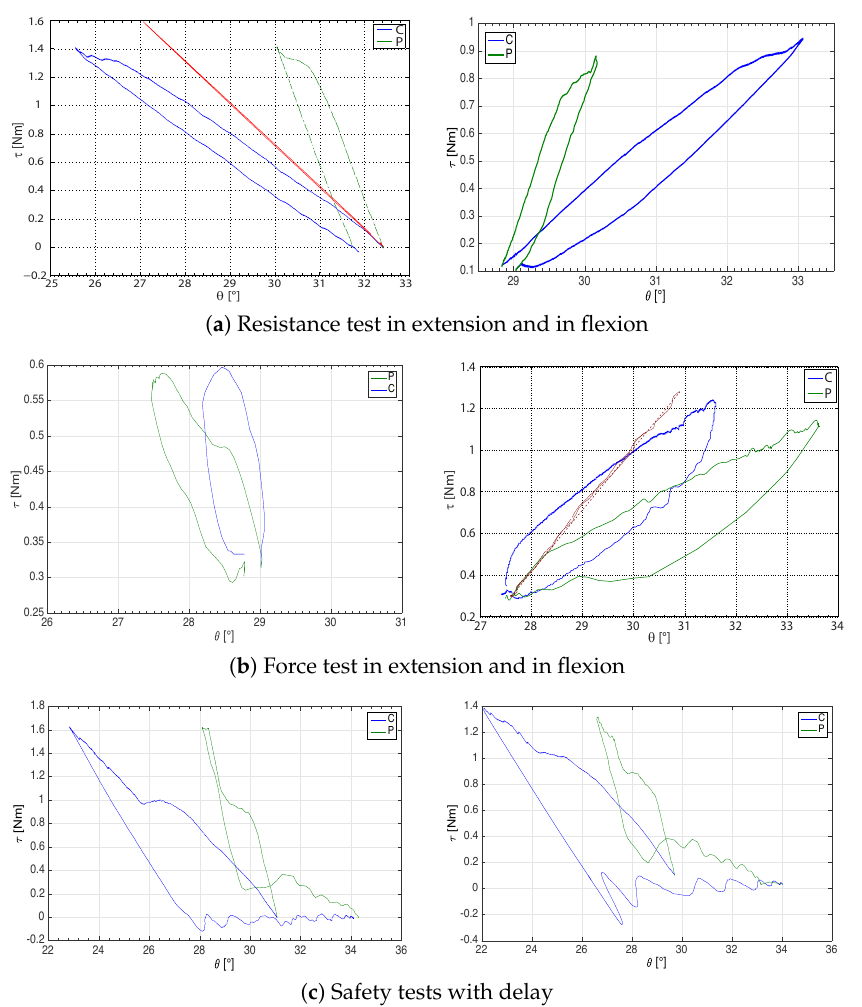
Figure 12. Examples of the torque-angle diagram during resistance ( top ) and muscular tests ( middle ) either in extension ( left ) or flexion ( right ). In addition, two examples of safety tests in the presence of a communication delay are shown during resistance tests in extension ( bottom ). The curves for both clinician (C, blue) and subject (P, green) are reported in the positive half-right plane. τ (Nm) indicates the torque; θ ( ◦ ) is the angle, which increases with flexion. The maximum-perceived-stiffness curves (see Section 5.2.3) are shown in